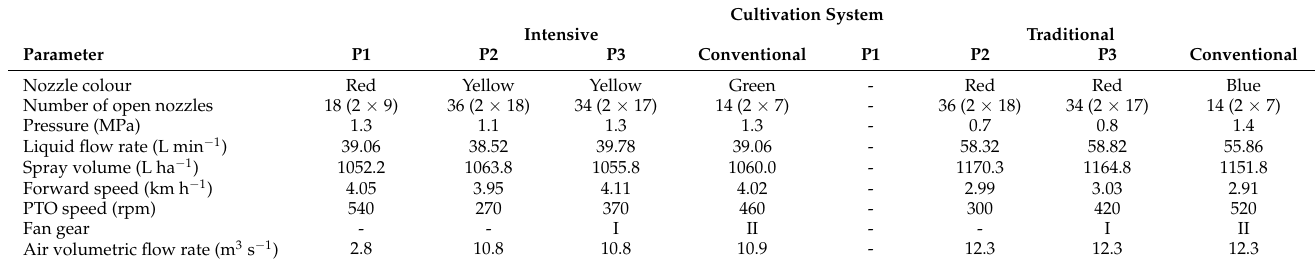
Table 2. Operational parameter values selected for every sprayer.